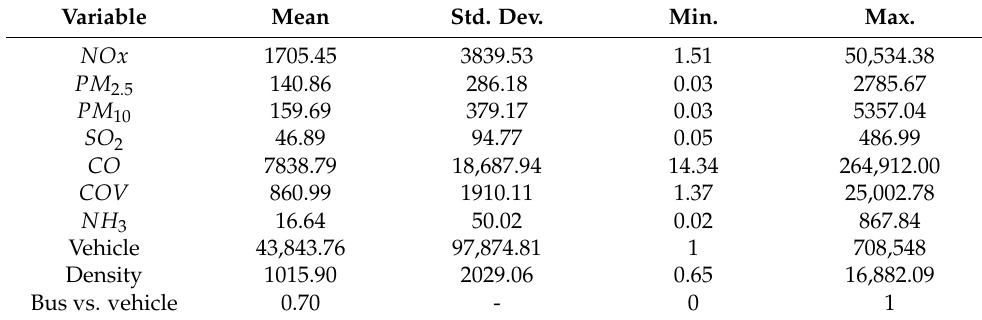
Table 2. Descriptive statistics.